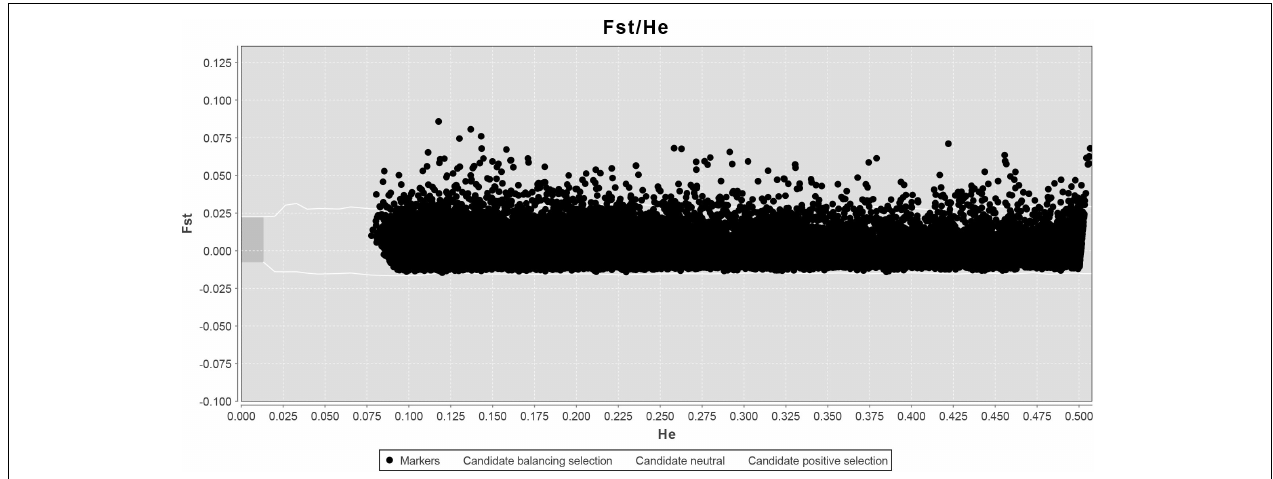
FIGURE 3 | Test for neutrality using LOSITAN based on 28,782 SNPs. Observed value of heterozygosity vs. F ST at each locus (black dots) and 95% confidence envelope expected under neutrality.